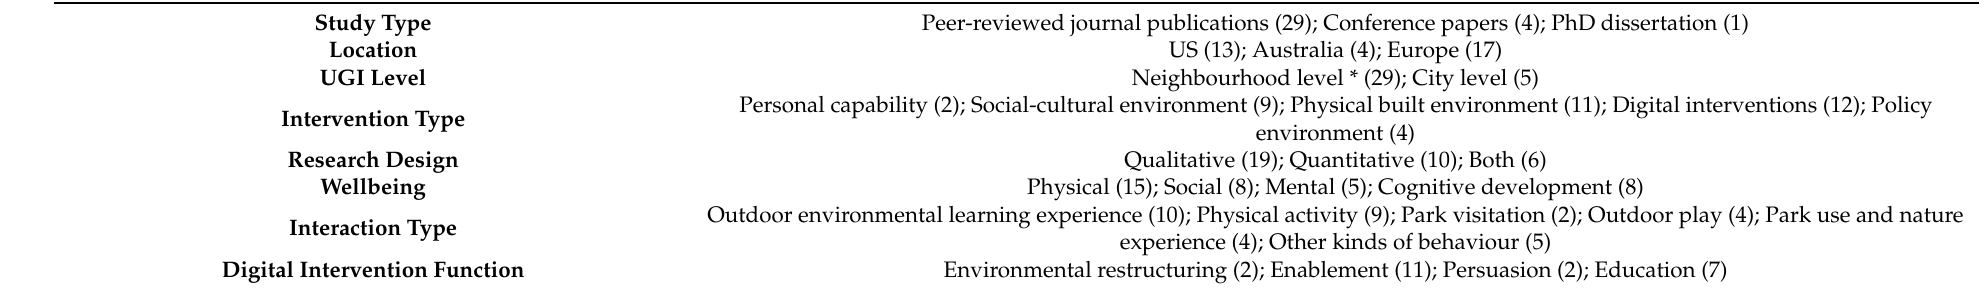
Table A1. Overview of the selected studies and their characteristics.